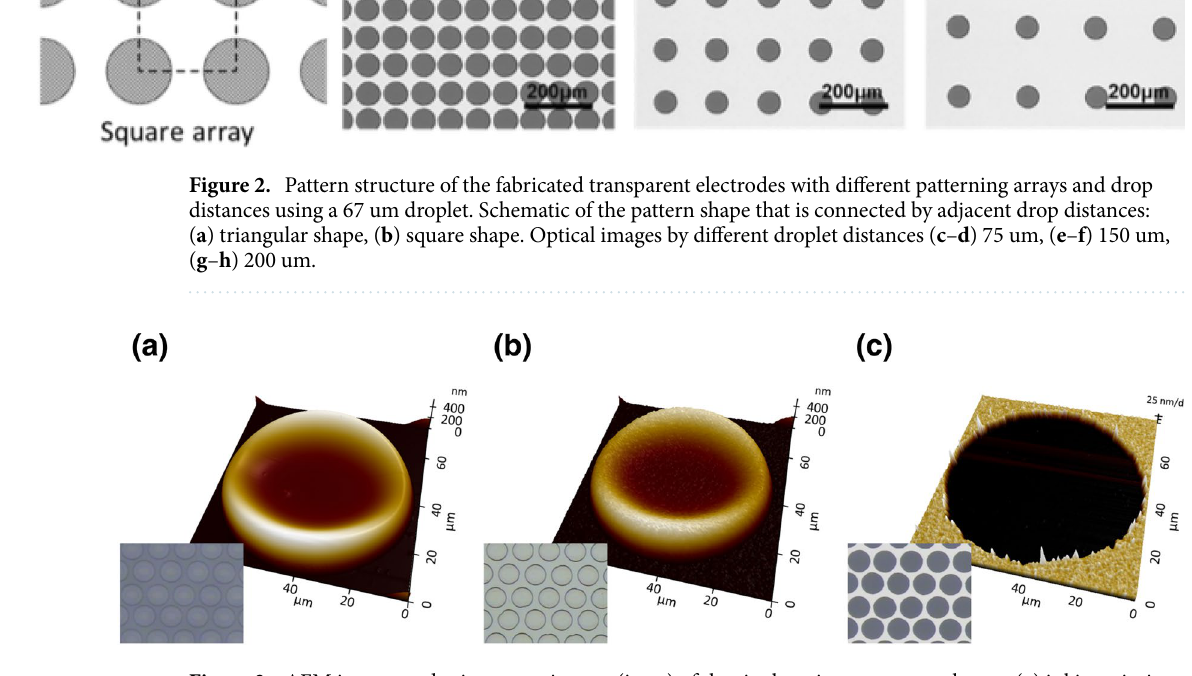
Figure 3. AFM images and microscope images (inset) of the single unit pattern at each step: ( a ) inkjet printing of the PR, ( b ) thermal evaporation of aluminum, and ( c ) removal of the sacrificial Figure 3a is an optical image of the patterned PR by ink-jet printing and an AFM image measuring the droplet shape of one of the patterns. There was a height difference in a printed droplet, which is known as the coffee ring effect because the shape is similar to a coffee stain mark. The coffee ring effect was formed from the difference in the relative evaporation rates of solvents during ink-jet printing. 26 Since the evaporation rates of the printed ink at the outside was higher than that of the ink at the inside, the height of the edge was higher than that of the center. The ink used for the printing of the sacrificial layer also exhibited the conventional characteristics of the coffee ring effect. The maximum height of the edge area was 555 nm and the height of the center was 112 nm. After the sacrificial layer was printed, aluminum was deposited using thermal evaporation. One hundred nm of aluminum was deposited on the whole region of the printed sample, both for the sacrificial layer region and the bare substrate region. The study confirmed that the optical image was bright in the microscope image of Fig. 3b. The printed pattern followed the profile of the sacrificial layer with a concave center area. The aluminum elec- trode with a negative pattern dot array was fabricated by removing the underneath sacrificial layer. The patterned droplets were neatly removed by sonication in acetone, resulting in a transparent electrode with a negative pat- tern, as shown in Fig. 3c. The removal of the aluminum layer with the pattern of the underneath sacrificial layer was similar to the liftoff process in conventional lithography. In a general liftoff process, the thickness of the PR should be 3 ~ 4 times thicker than that of the metal layer because the height difference by the photoresist should be high enough to break the metal bonding. Though the thickness of the inkjet-printed sample was similar to the aluminum layer, the negative pattern was formed clearly and was attributed to the coffee-ring effect. Since the thickness of the edge was about 5 times higher than the center, the printed sacrificial layer gained the effect of a layer thick enough to break the metal bonding. We measured the adhesion strength of the transparent electrode fabricated by tape test. Figure S1 shows that there was little change within 19 Ω/ □ during peeling. Therefore, it confirmed that the adhesion between the substrate and the deposited aluminum was very good. Abrasive resistance test helps ensure that the material’s original structure and look are maintained. We measured the friction coefficient according to the distance by applying a load of 1 N and a speed of 1 cm/s through the Ball-on-Disc method. Through Figure S2, it was con- firmed that the friction force of the fabricated transparent electrode was 0.947 N.